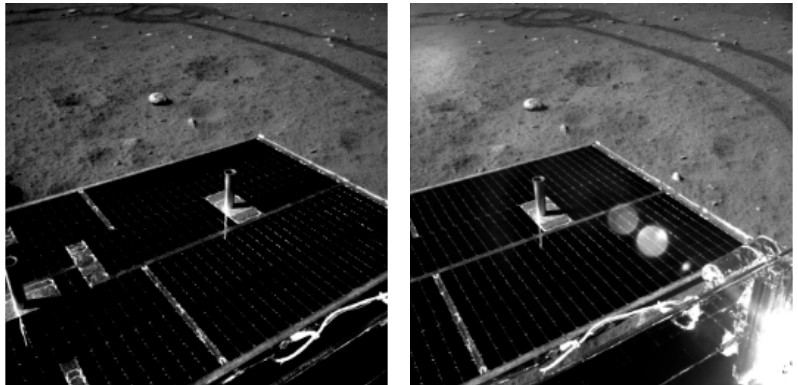
Figure 3. Images captured by the navigation cameras. During extraction, the extracted lines are optimized and straightened based on the extracted edges. Specifically, based on the gradient template shown in Figure 4, the gradient magnitude and direction of the pixels are calculated, and the average gradient direction of the 3 × 3 neighborhood pixels is used to replace the original gradient of the pixel. By traversing the entire image, the gradient magnitude and direction of all pixels are obtained. Figure 5 shows the histograms of gradient directions of four navigation